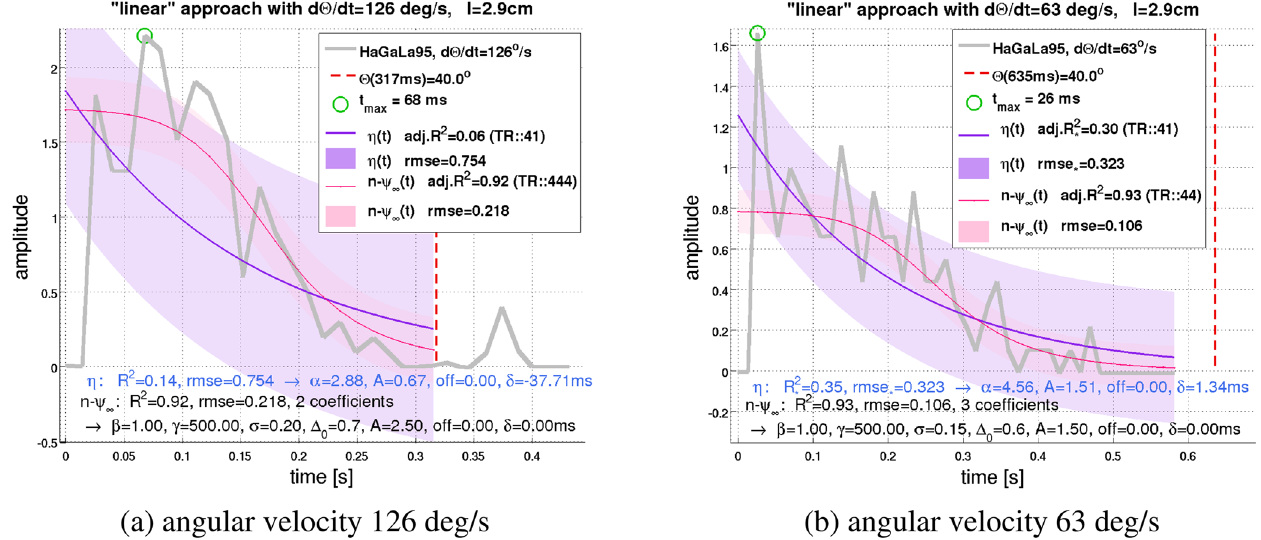
Fig 7. LGMD stimulation with constant angular velocity. The original data (legend label “ HaGaLa95 ” ) were resampled from ref. [16] and show DCMD responses to an object approach with _ Y ¼ const , what is equivalent to that Θ increases linearly with time. The η -function ( FITTING FUNCTION : A (cid:2) ( t + δ )+ o ) and n- ψ Eq (10) were fi tted to these data (see Section D in S1 Text for speci fi cs). ( a )(Figure 3 Di in [16]) Good fi ts for n- ψ are obtained with σ = 0.2 and Δ follows a sigmoid-like curve that (subjectively) appears to fi t the original data better than η . The fi tting parameters for η were { A , α , δ , o } ( “ TR:41 ” ), and { σ , Δ 0 } for n- ψ ( “ TR:444 ” ). ( b )(Figure 3 Dii in [16]) The fi t of n- ψ agrees excellently with the data for σ = 0.15 and Δ 0 = 0.6. The fi tting parameters for n- ψ were { β , σ , Δ 0 } ( “ TR:44 ” ). Figure D26 in S1 Text shows how the linear approach data could also be predicted by explicitly integrating n- ψ instead of fi tting the equilibrium